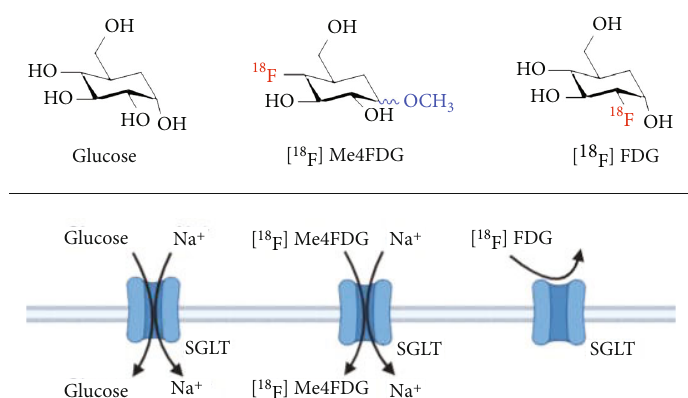
Figure 1: Molecular structures of [ 18 F]Me4FDG, [ 18 F]FDG, and glucose and their interaction with